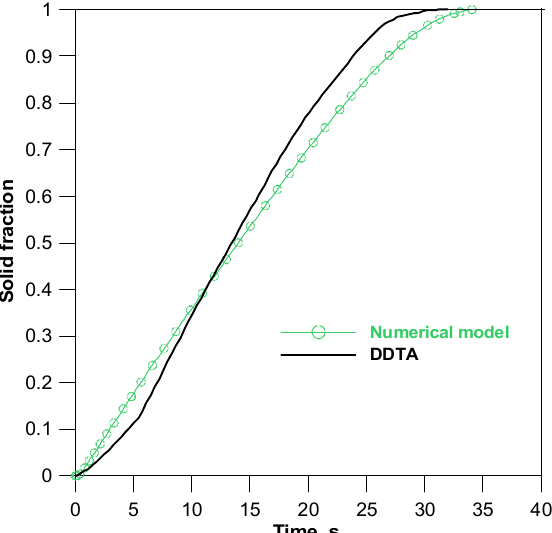
Figure 10. Comparison of the growth kinetics of the solid fraction calculated in the CA solidification model with DDTA tests.